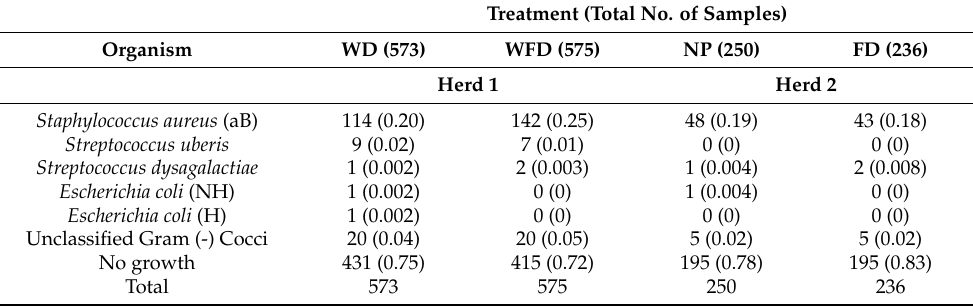
Table 3. Bacteriological results of all quarter samples (including clinical and subclinical samples) for four pre-milking teat treatments on two herds (Herd 1 = WD (a water wash and dry wipe) and WFD (a water wash, foam application and dry wipe); Herd 2 = NP (no teat preparation) and FD (foam appliaction and dry